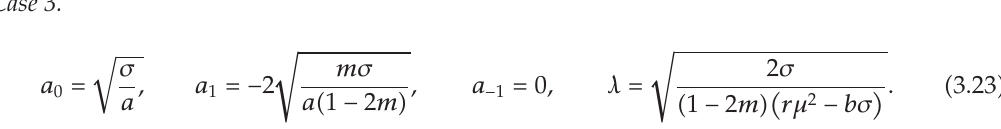
Figure 4: (cid:3) a (cid:4) The solitary wave graph of (cid:3) 3.19 (cid:4) with a (cid:8) r (cid:8) σ (cid:8) 1 , b (cid:8) 2 at t (cid:8) 1, and (cid:3) b (cid:4) is its plane when y (cid:8) 0 (cid:3) the case is the same to (cid:3) 3.17 (cid:4) when m (cid:8) 1 (cid:4) . Case